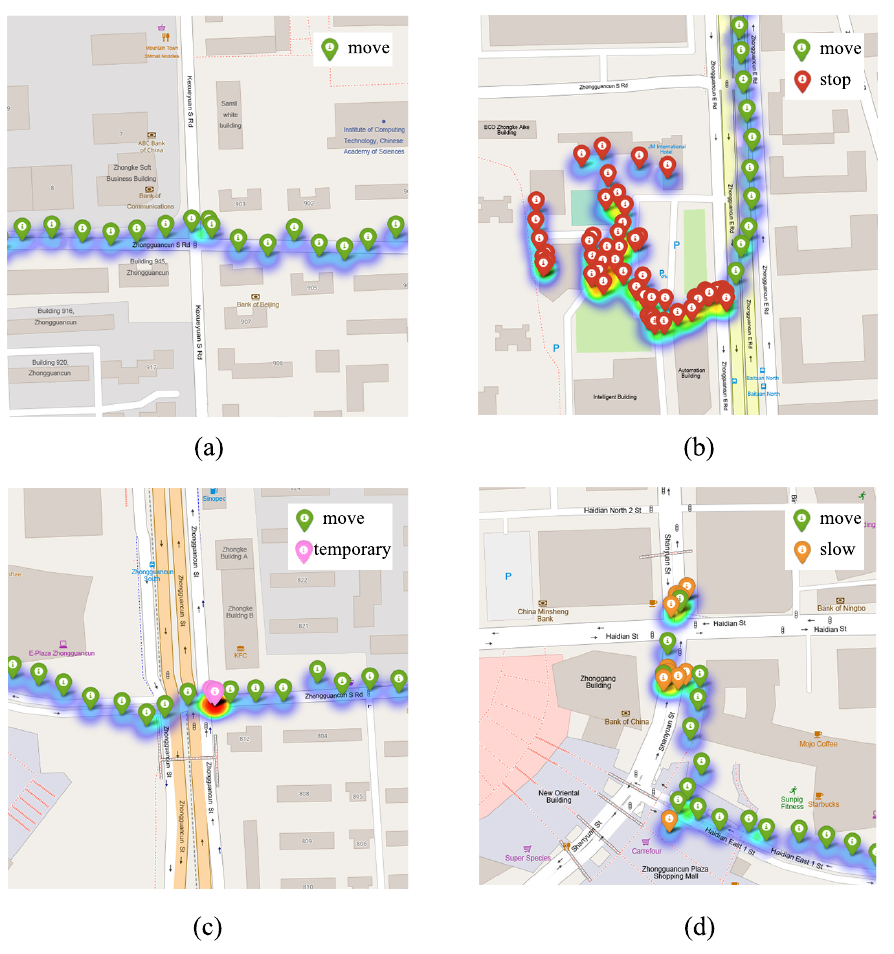
Figure 1. Typical distribution diagram of different types of points: ( a ) moving points, ( b ) stopping points, ( c ) temporary stopping points, ( d ) slow moving